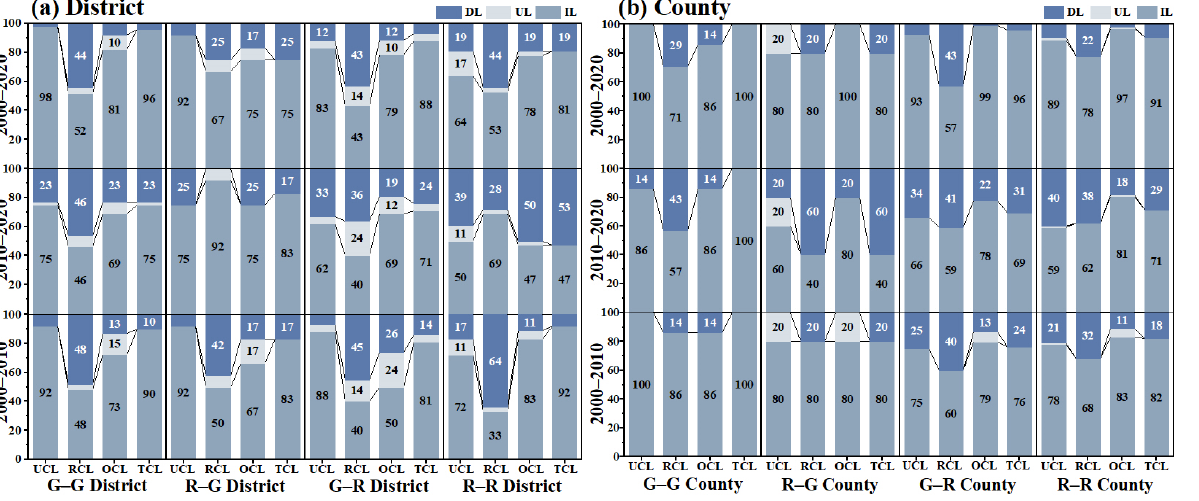
Table 1. Growth rate of new construction land in various research units, 2000–2010 and 2010–2020.